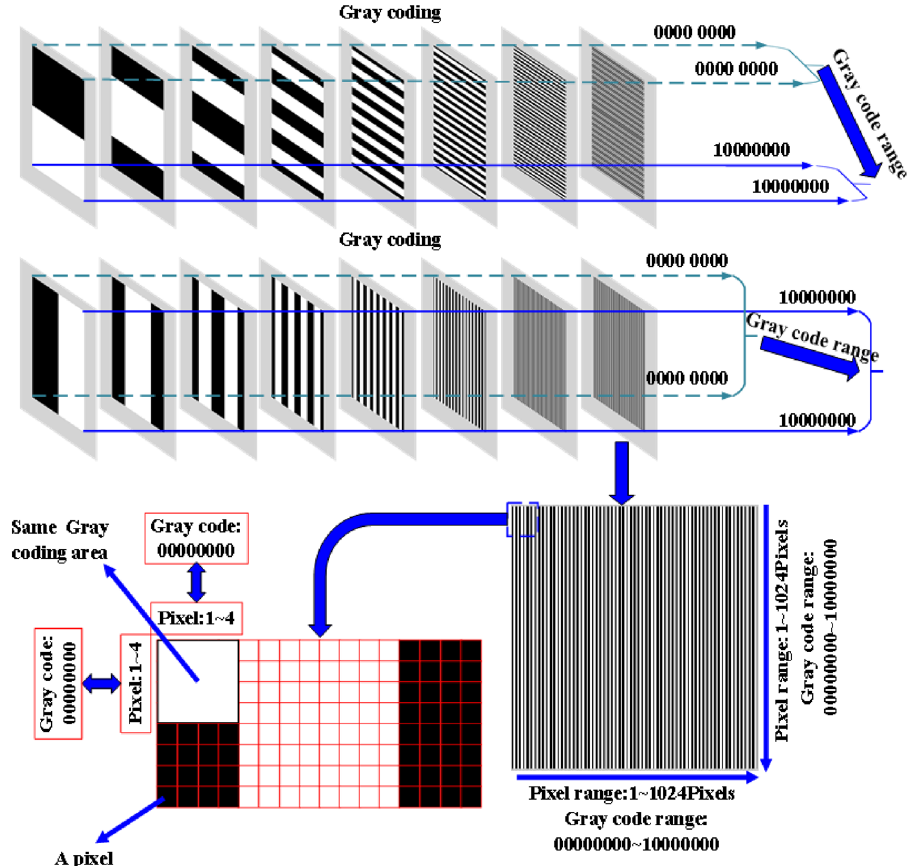
Figure 2. Rough mapping based on Gray coding